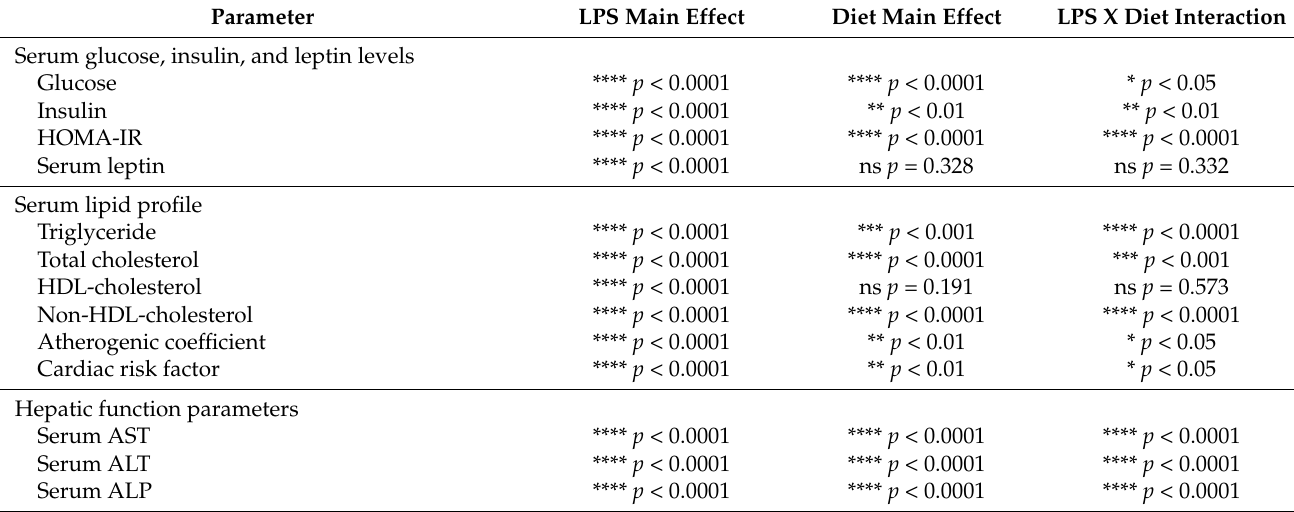
Table 5. Summary of statistical analysis by two-way analysis of variance (ANOVA) for main effects and interactions.